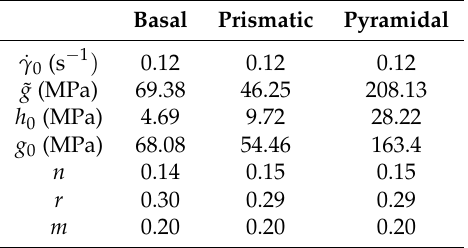
Table 2. Crystal plasticity parameters for Ti-6242 α p particles at 1172 K.